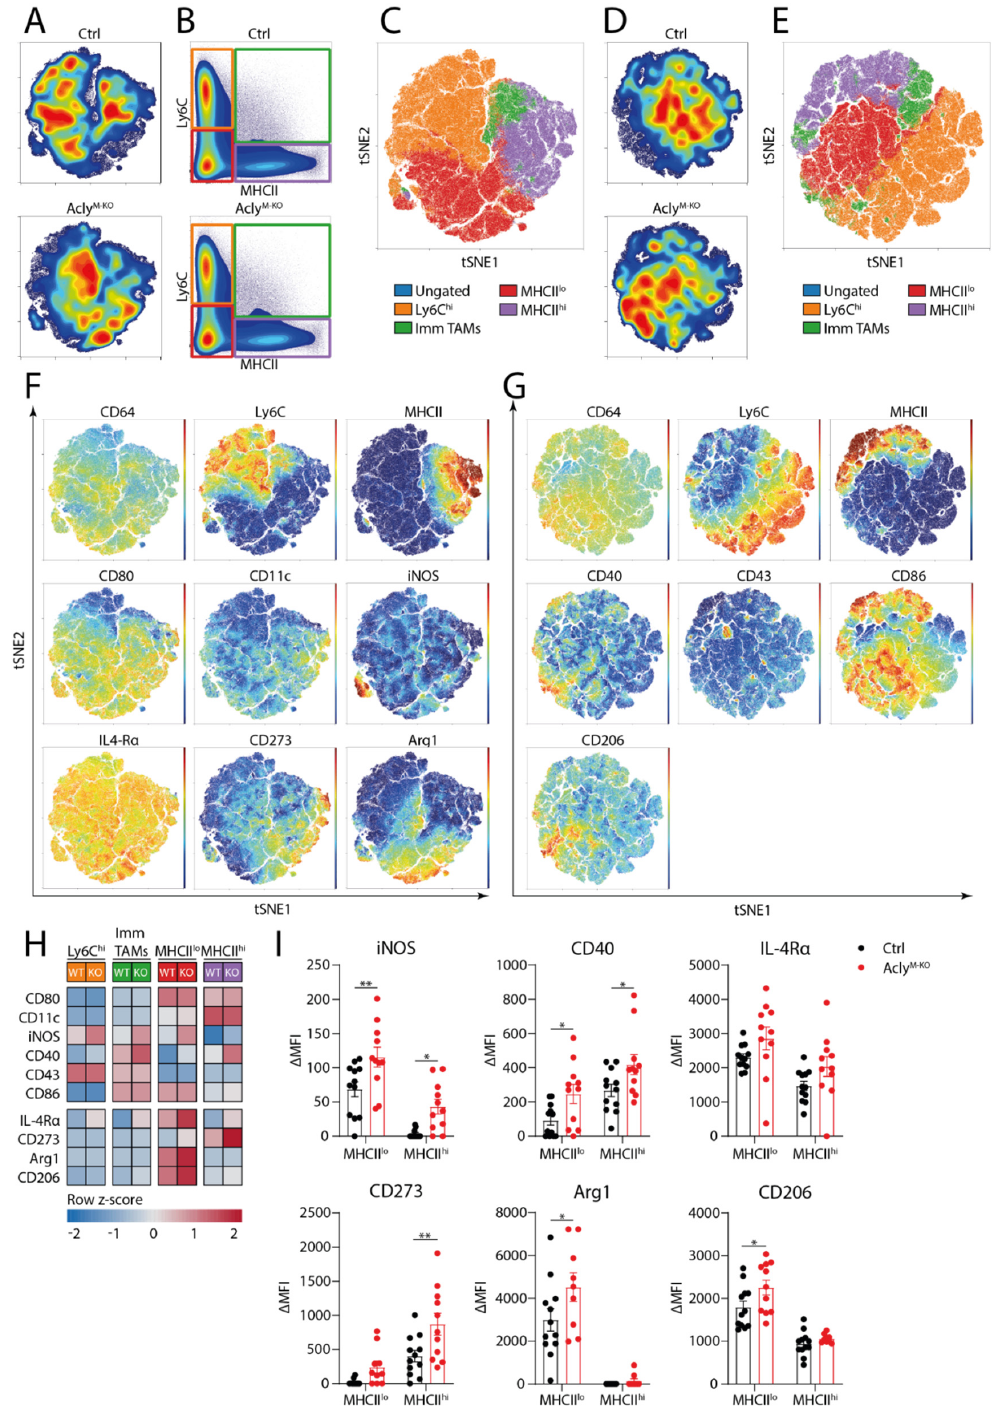
Figure 4. Acly M-KO modulates in vivo TAM phenotype in a 3LLR tumor model. ( A , D ) Density distributions of con- trol and Acly M-KO mice over unsupervised clustering plots of CD11b + Ly6G − CD64 + myeloid cells. ( B ) Manual gat- ing of MHCII/Ly6C subsets and ( C , E ) overlays of these subsets on tSNE clustering. ( F , G ) Unsupervised clustering of CD11b + Ly6G − CD64 + cells according to MHCII/Ly6C expression and expression of selected pro- and anti-inflammatory macrophage markers. ( H ) Heatmap of Ly6C hi , Immature TAMs, MHCII lo and MHCII hi TAM subset macrophage marker expression and ( I ) ∆ MFI of selected macrophage markers for MHCII lo and MHCII hi TAM subsets of control and Acly M-KO mice. ∆ MFI was calculated as MFI(sample)-MFI(FMO) on the same subset. P -values are indicated as <0.05 *, <0.01 **. Results are shown as mean ±